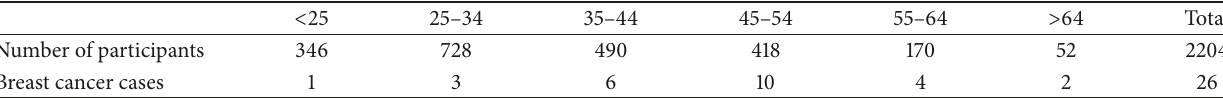
Table 4: Breast cancer cases in relation to numbers and